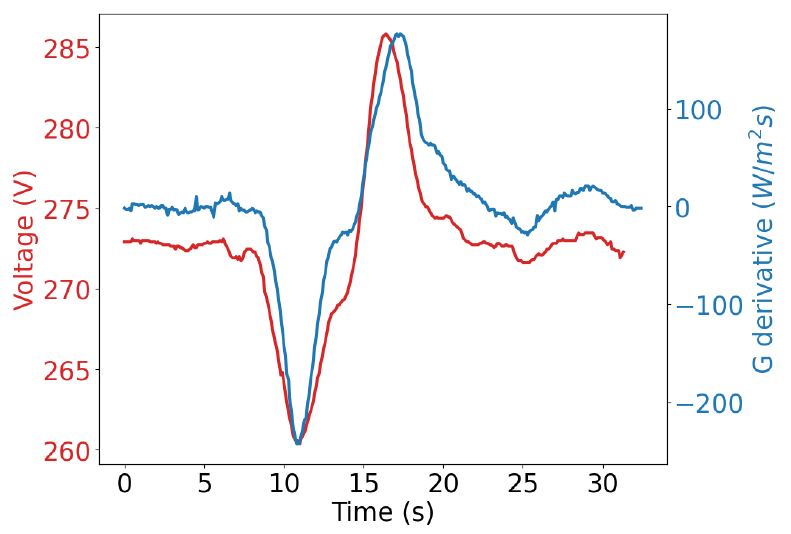
Figure 8. Voltage and derivative of irradiance